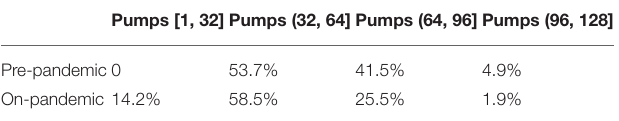
TABLE 3 | Distribution of men in pump